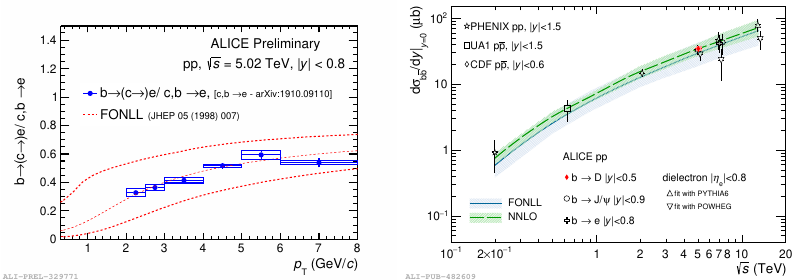
Figure 1. Left: Fraction of beauty-hadron decay electrons to heavy-flavor hadron decay electrons in pp collisions at √ s = 5.02TeV. Right: Beauty production cross section per unit of rapidity at midrapidity as a function of √ s measured in pp and p¯p collisions by di ff erent experiments